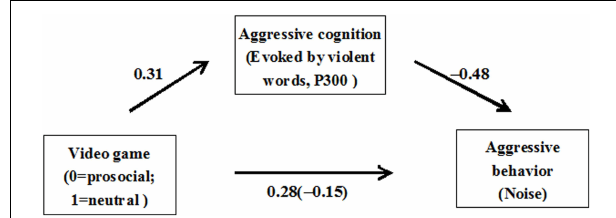
FIGURE 4 | Mediating effect of aggressive cognition (P300) on video game to predict